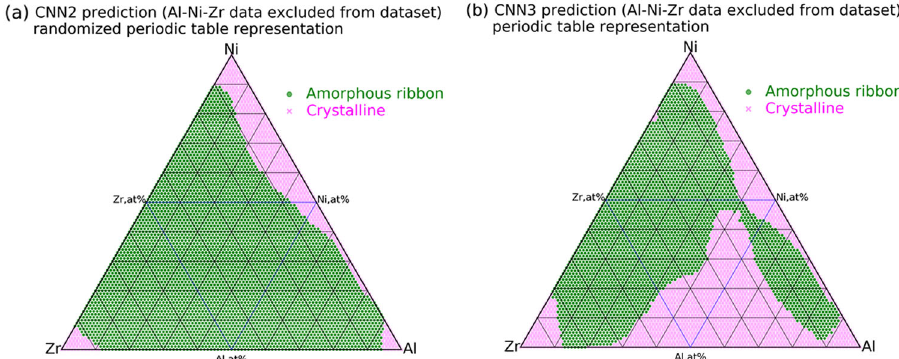
Fig. 4 Predictions for Al – Ni – Zr ternary system by the re-trained models. a CNN2, b CNN3, using dataset in which data about Al – Ni, Al – Zr, Ni – Zr binary alloys, and Al – Ni – Zr-containing multi-component alloys were removed.